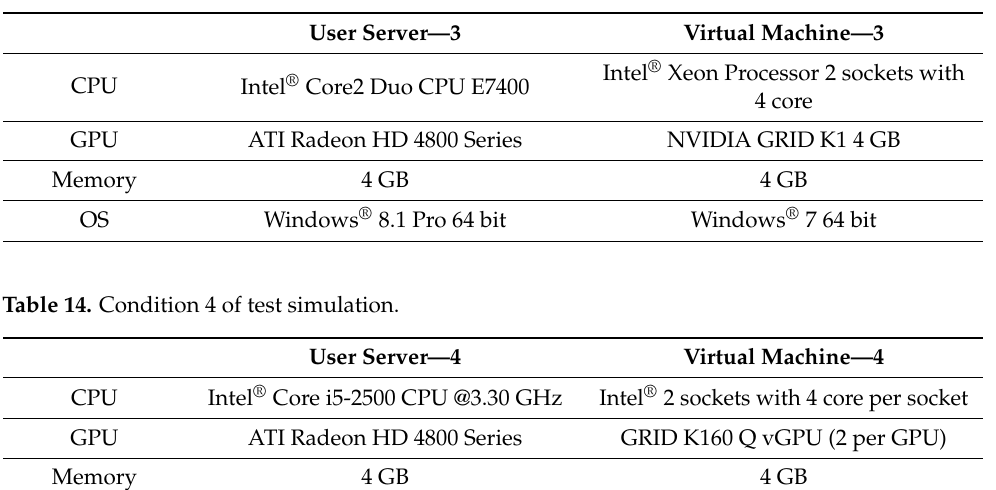
Table 13. Condition 3 of test simulation.